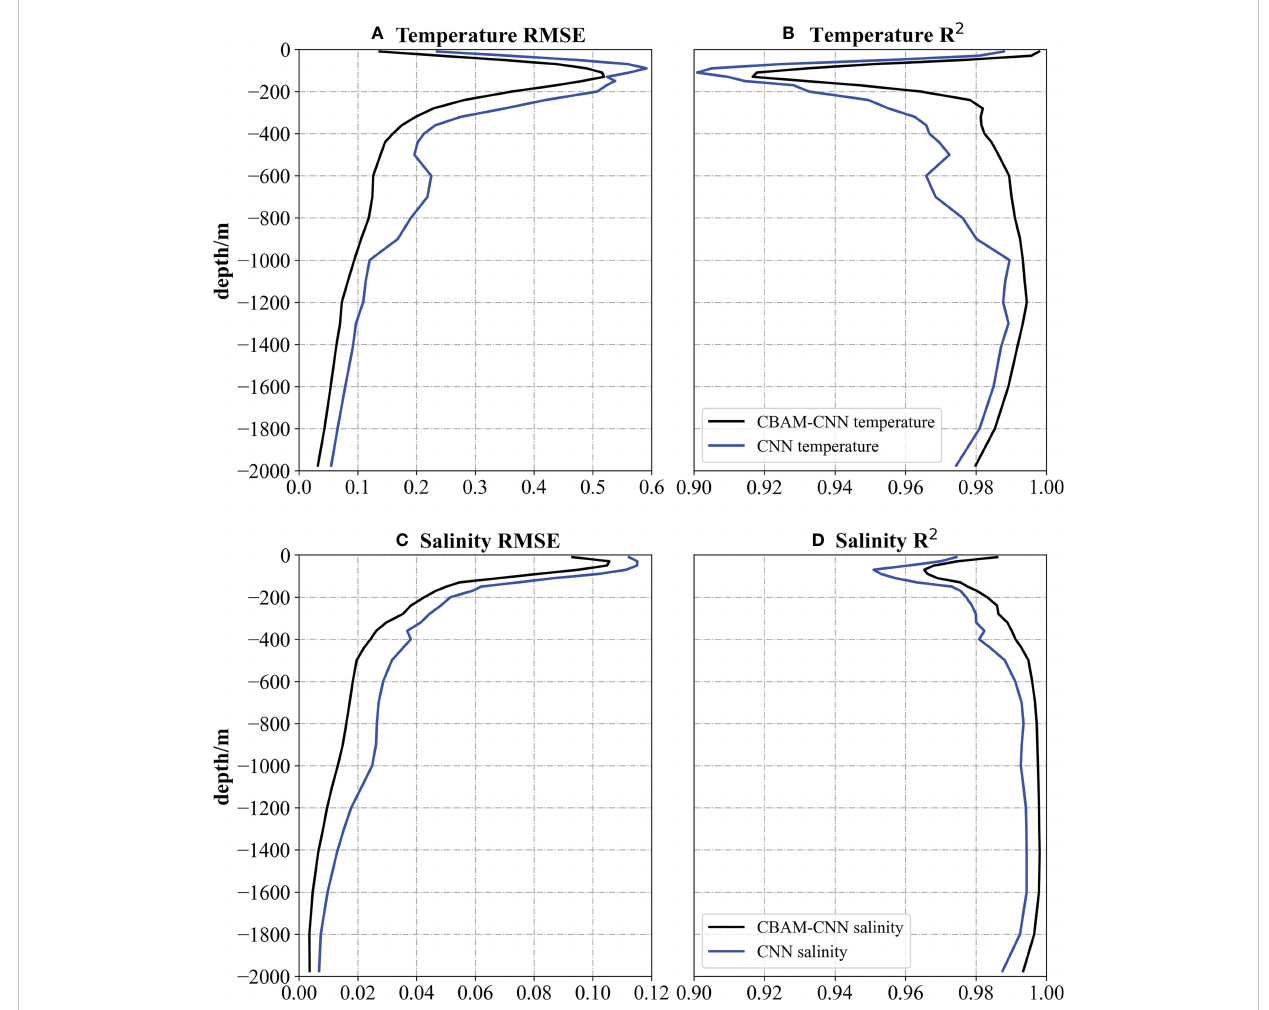
FIGURE 4 Comparison of the CBAM-CNN model (black line) with CNN model (blue line) for OSTS and OSSS estimation at different depths based on (A, C) RMSE (°C) and (B, D) R 2 in